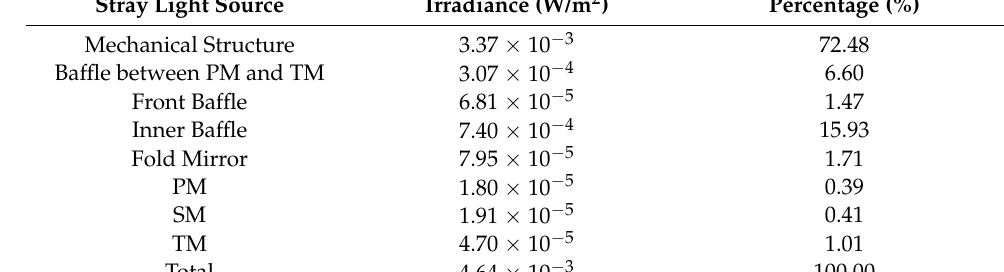
Table 2. Irradiance received by the THz detector.